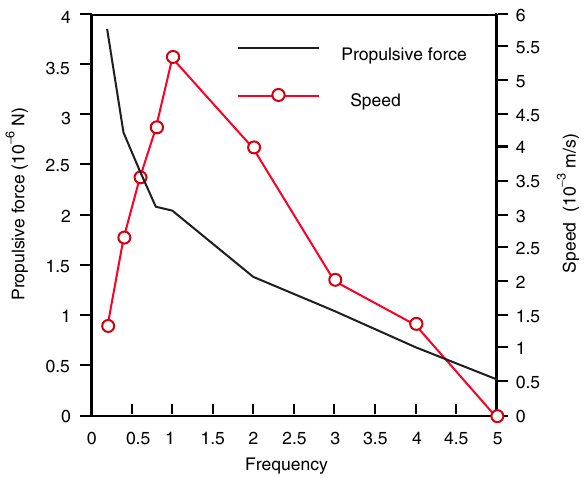
Figure 14 Experimental results (2.5 V). 20 measurements is used as the final test data. By changing the frequency from 0.2 to 5 Hz at 2.5 input, the experi- mental results of the average propulsive force and the av- erage speed are shown in Figure 14. Experimental results